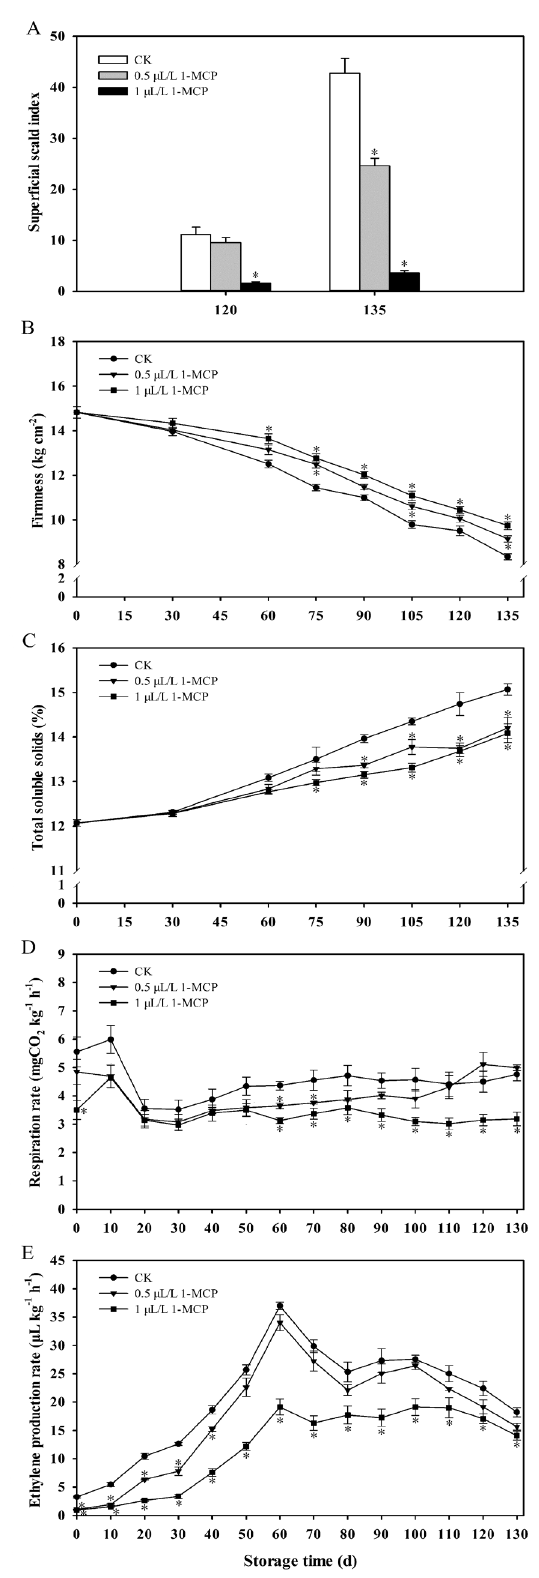
Fig. 1: Effects of 1-MCP on superficial scald index (A), firmness (B), total soluble solids (C), respiration rate (D), and ethylene production rate (E) in ‘Wujiuxiang’ pear fruits during storage at 0 °C. The data are the means ± SE of three replicates. The vertical bars represent the standard errors of the means. Star represents significant difference ( P <